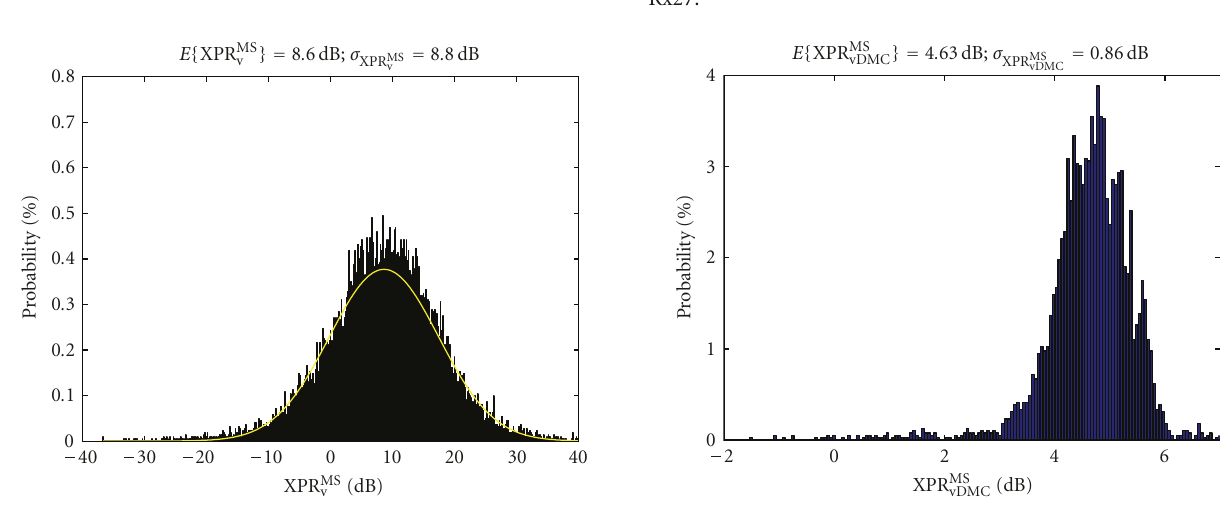
of the SCs, macrocell Rx19 to Rx27. h